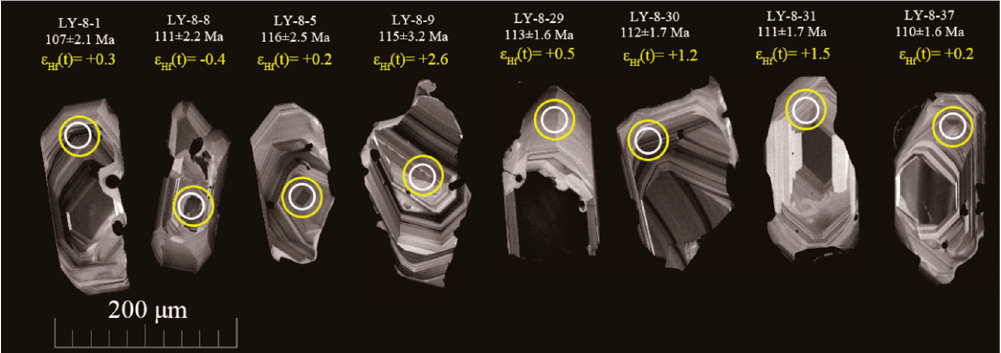
Figure 4. Cathodoluminescence (CL) images of selected zircon crystals from representative Muchen quartz monzonite and granite. The morphology of zircon grains, 206 Pb/ 238 U ages, ε Hf (t) values are shown. Small white spots indicate U-Pb dating positions of laser ablation-inductively coupled plasma-mass spectrometry (LA-ICP-MS), and large yellow spots indicate the sites of Hf isotope analyses of LA-MC-ICP-MS, with spot diameters showing the approximate laser spot sizes.